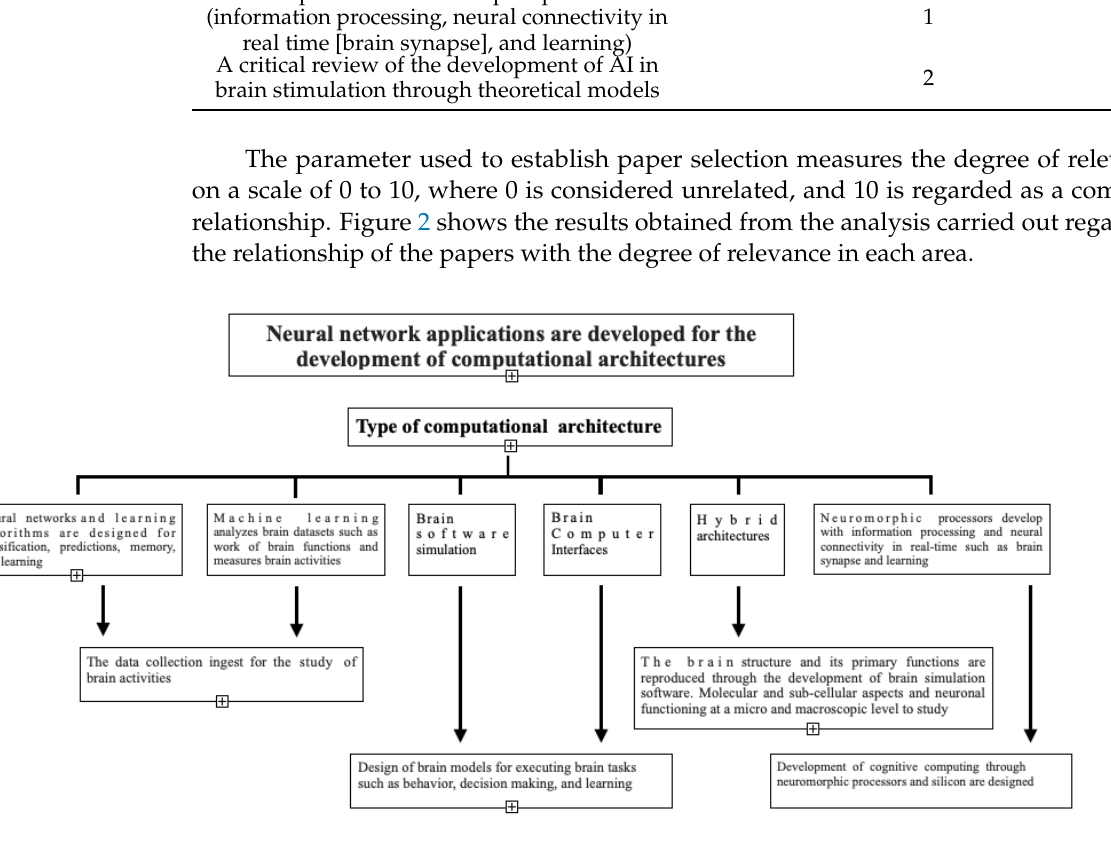
Figure 2. Neural networks applications and the main areas in which they are